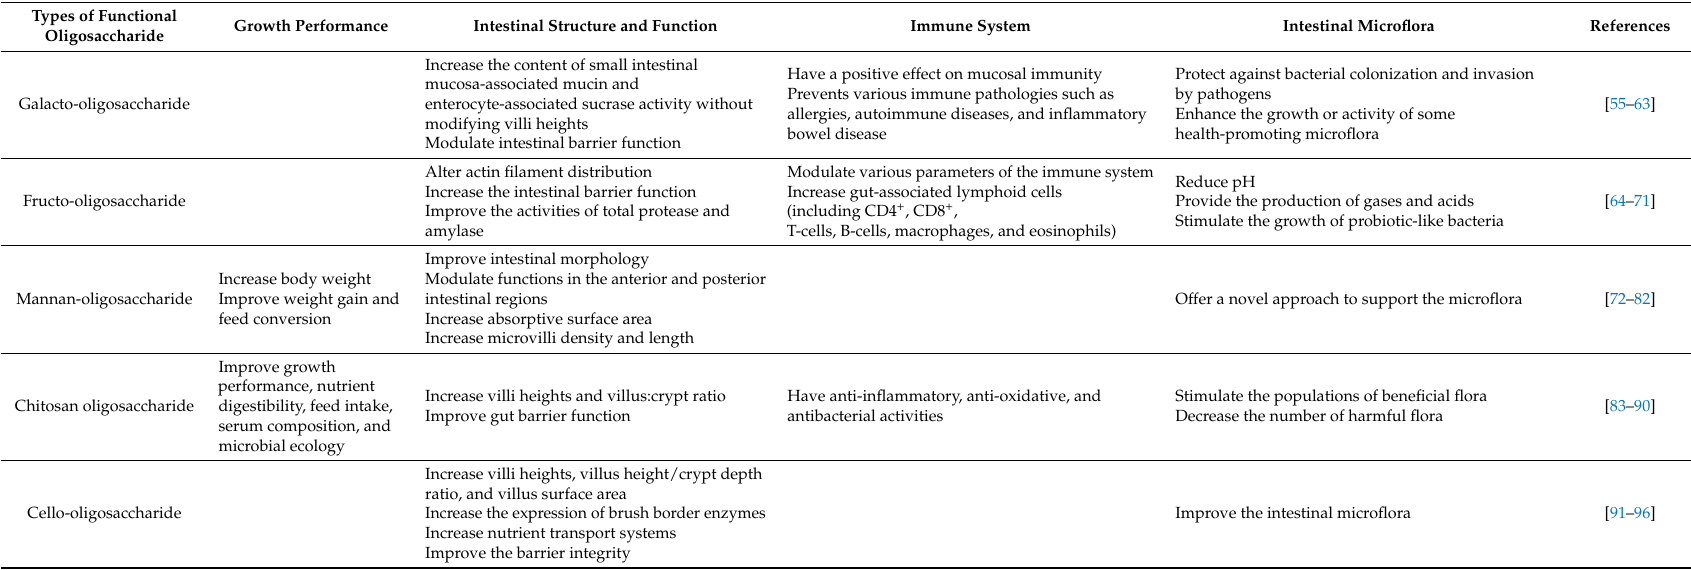
Table 1. The main functions of different functional oligosaccharides on the intestinal